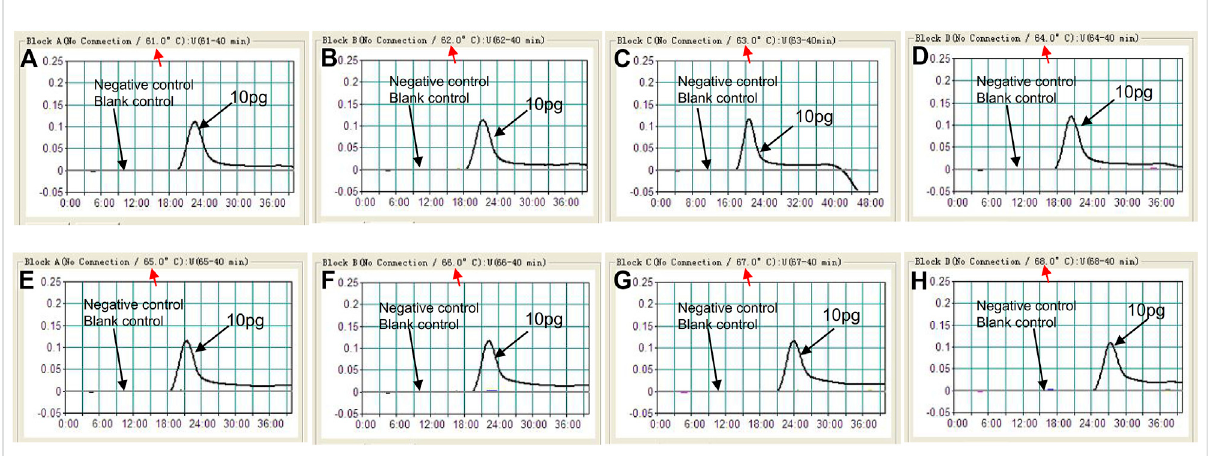
FIGURE 3 Optimization of ampli fi cation temperature for the C. albicans -LAMP primer set. The LAMP reactions for detection of C. albicans were monitored through realtime turbidity (LA-500), and the corresponding curves of concentrations of templates were marked in the fi gures. Eight kinetic graphs (A – H) were generated at various temperatures (61 – 68 ° C, 1 ° C intervals) with target pathogens DNA at the level of 10 pg per tube (The threshold value was 0.1 and the turbidity of > 0.1 was considered to be positive). The graphs from B (62 ° C) to E (65 ° C) showed robust reaction. The optimal ampli fi cation temperature was 64 ° C.